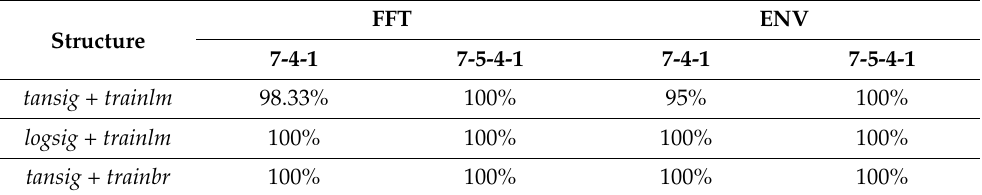
Table 3. Comparison of the effectiveness of the fault detectors of type I (0–1 detectors).